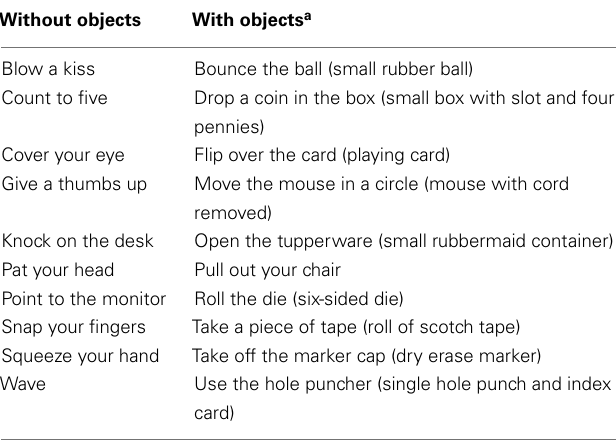
Table 1 |Actions performed during the hand-use